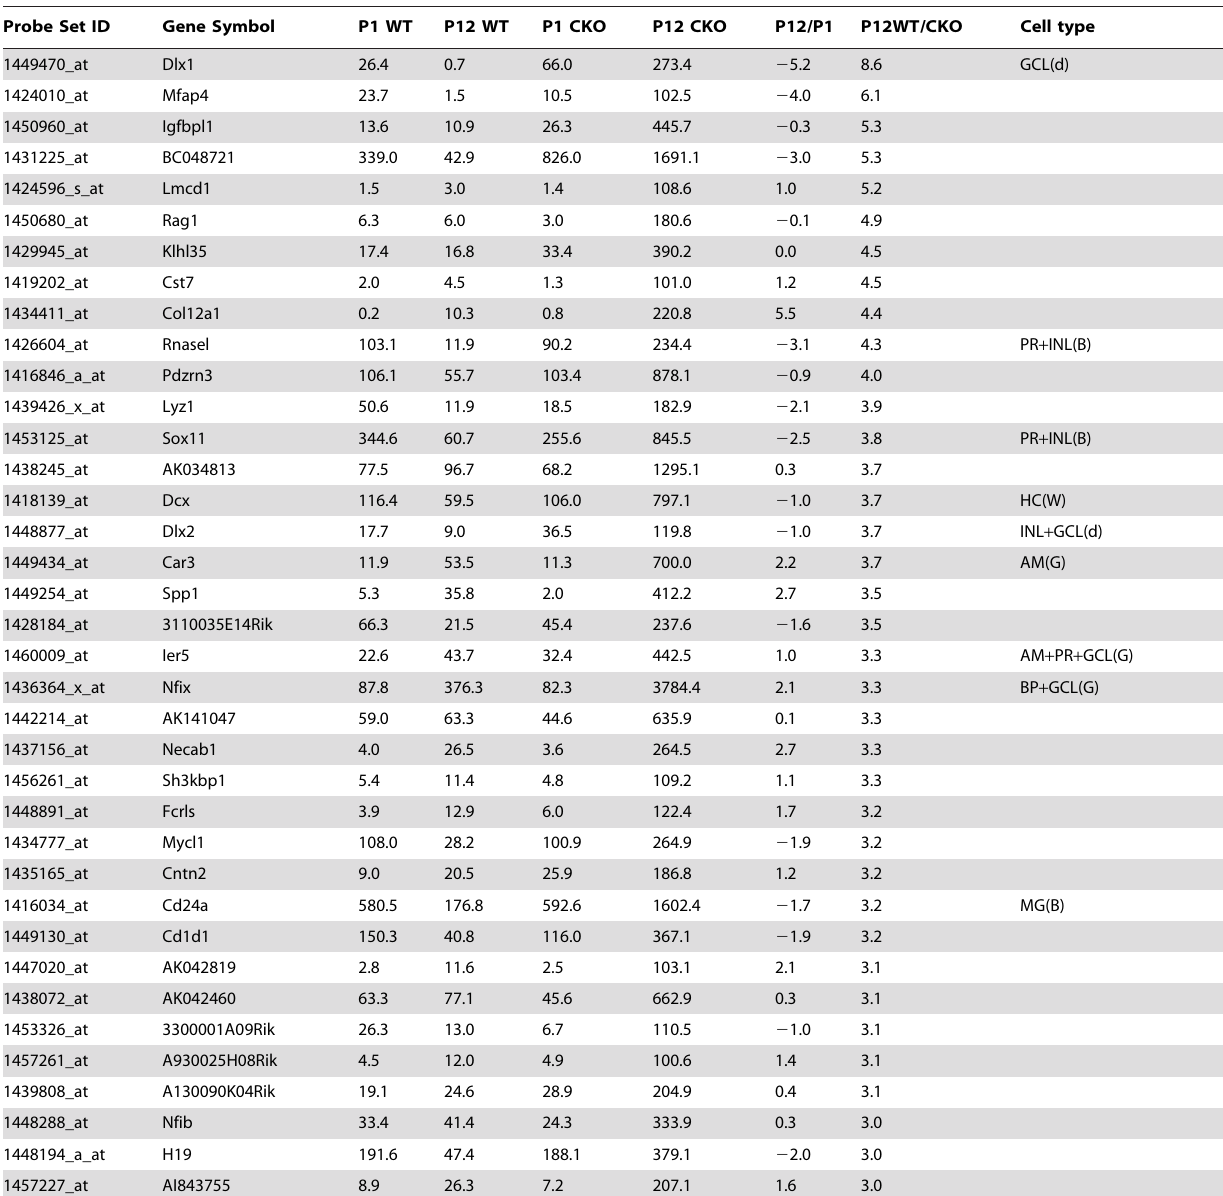
Probe Set ID Gene